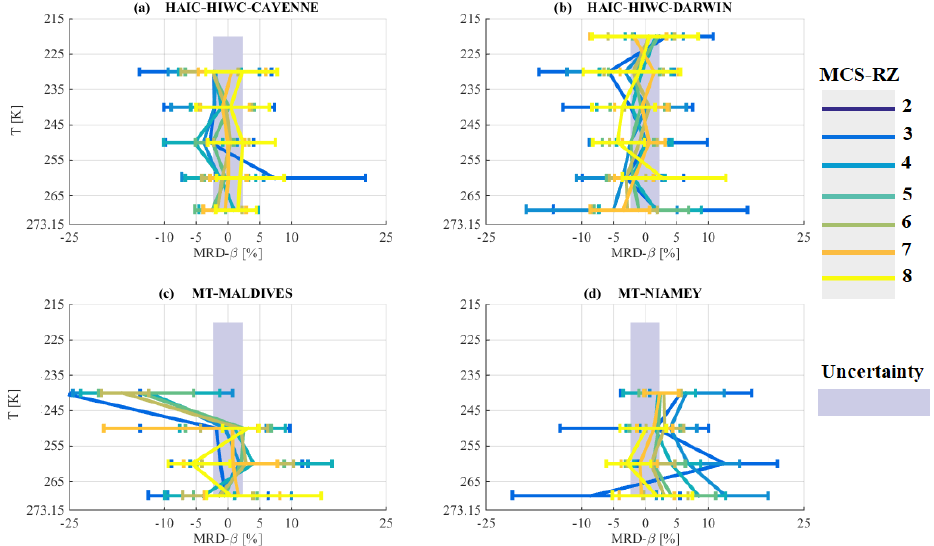
Figure 14. The same as Fig. 6 but for the exponent of mass–size relationship MRD- β